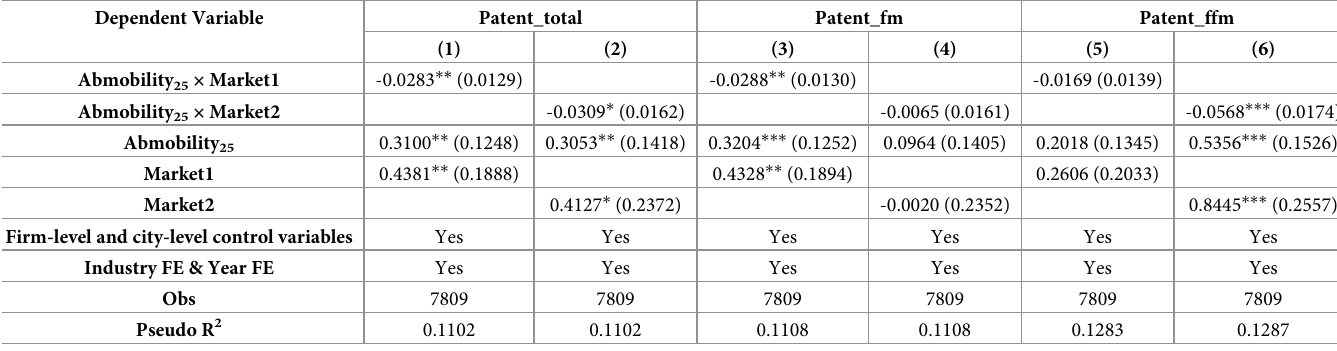
Table 11. Heterogeneity test of market-oriented